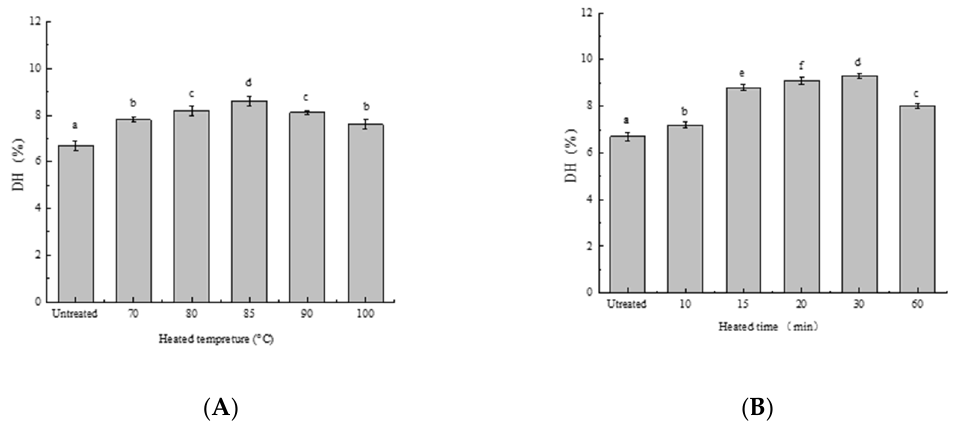
Figure 2. The Degree of Hydrolysis Measurement of SPI in vitro after treatment at different ( A ) temperatures and ( B ) times. The data with different letters are significantly different ( p < 0.05).